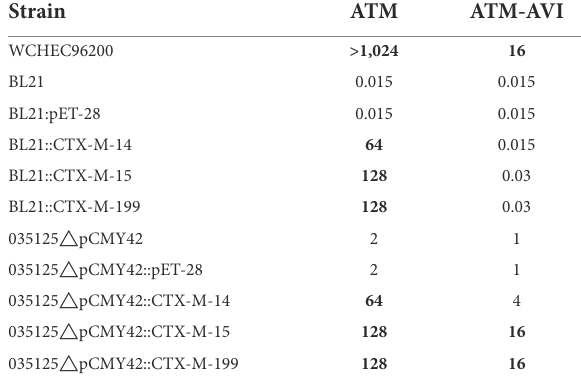
TABLE 1 MICs (mg/L) of ATM and ATM-AVI against strains used in this study. Strain ATM